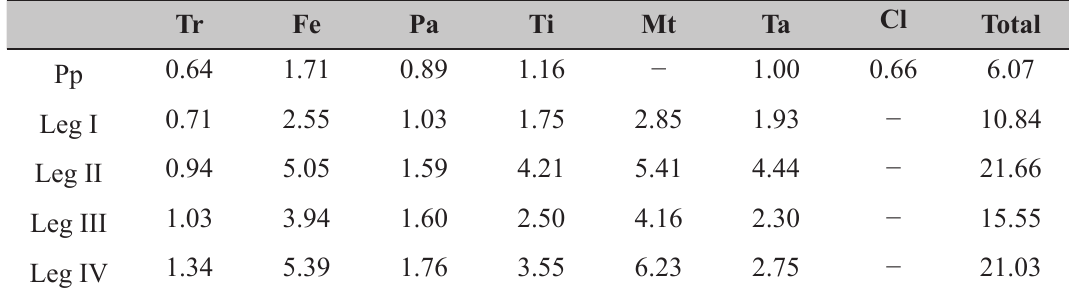
Table 7. Leg measurements of Lacronia serripes (Mello-Leitão, 1923), ♀ (MZSP 9973). Tr Fe Pa Ti Mt Ta Cl Total Pp